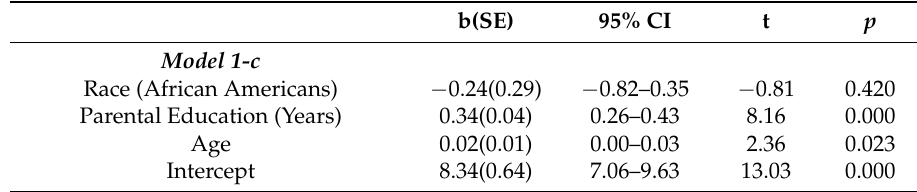
Table 3. Linear regressions between race, parental education attainment, and upward educational mobility in